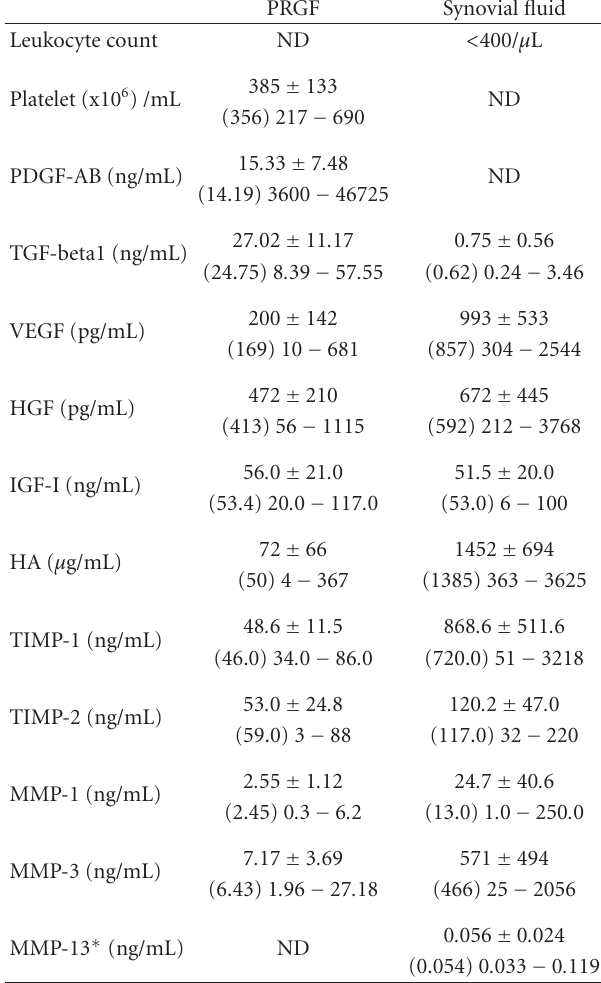
Table 1: Levels of hyaluronic acid (HA), matrix metallopro- teases (MMP-1, MMP-3, and MMP-13), tissue inhibitors of metalloproteases (TIMP-1 and TIMP-2), platelet-derived growth factor (PDGF-AB), transformed growth factor (TGF-beta), vascu- lar endothelial growth factor (VEGF), hepatocyte growth factor (HGF), and insulin-like growth factor (IGF-I) were measured on knee synovial fluid and in platelet-rich plasma (PRP) releasate at a single point in time. Results are shown as mean ± SD, (median), and range (ng-pg/mL). ND not detected. ∗ MMP-13 was measurable only in 13 of the 63